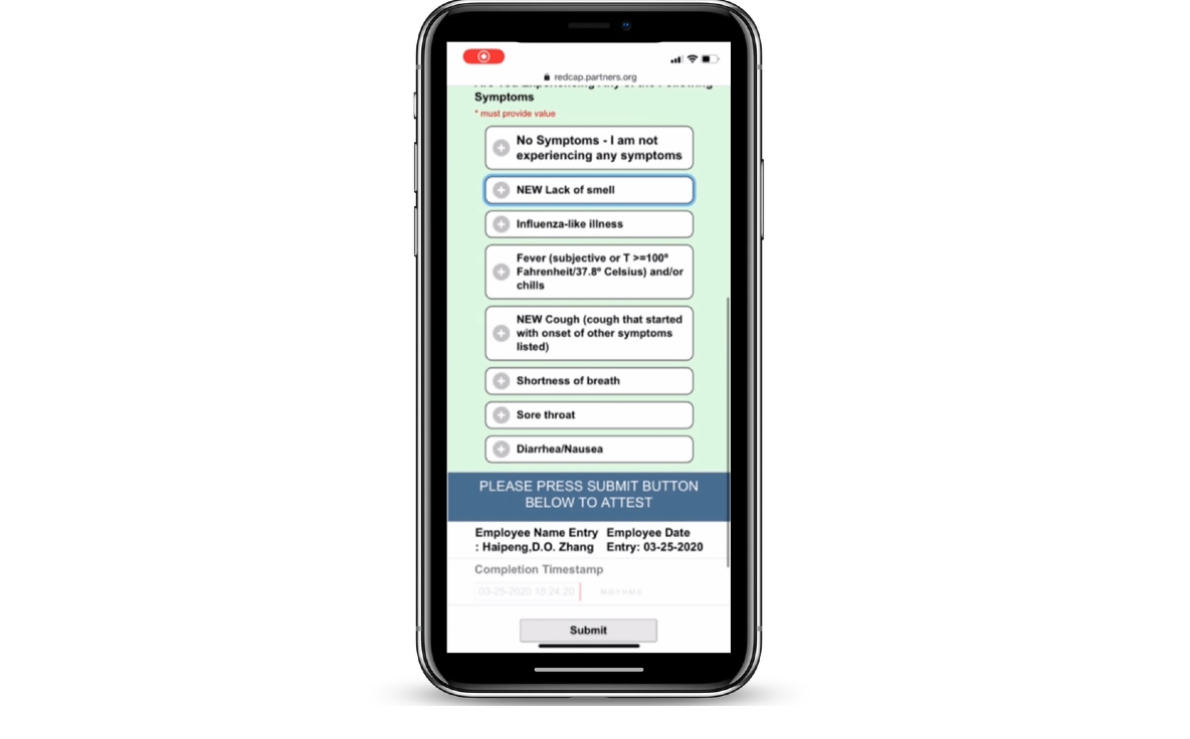
Figure 1. Employee symptom reporting screen of the COVID Pass application.